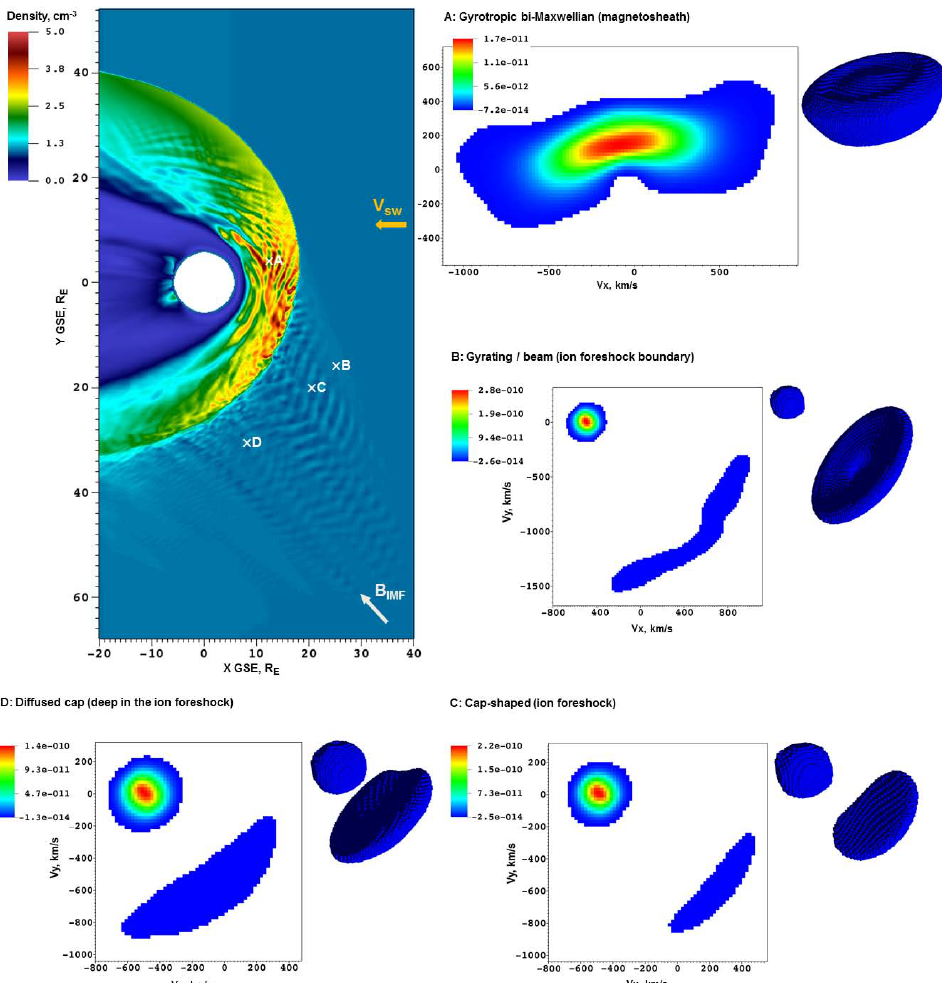
Fig. 1. Ion distributions (in units s 3 m − 6 ) in the magnetosheath ( A ), near the ion foreshock boundary ( B ), and in the ion foreshock ( C and D ).